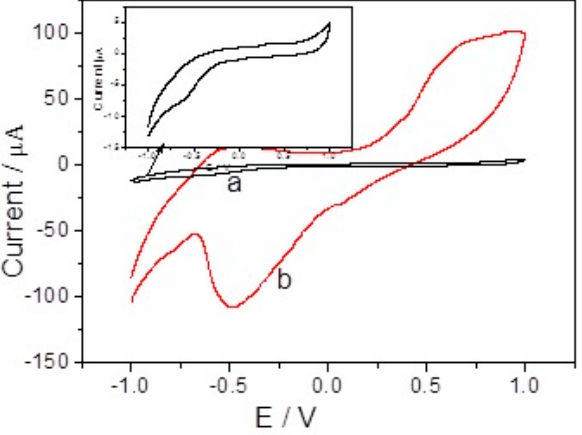
Figure 4. CVs of bare electrode (a) and branch-trunk Ag hierarchical nanostructures/GCE (b) in 0.1 M PBS (pH = 7.4) in the presence of 0.5 mM H 2 O 2 . Scan rate: 50 mVs − 1 .